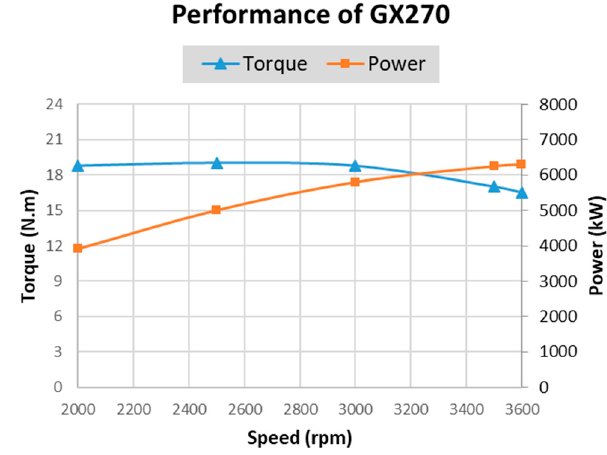
Figure 2. Performance of Honda GX270 engine [7].